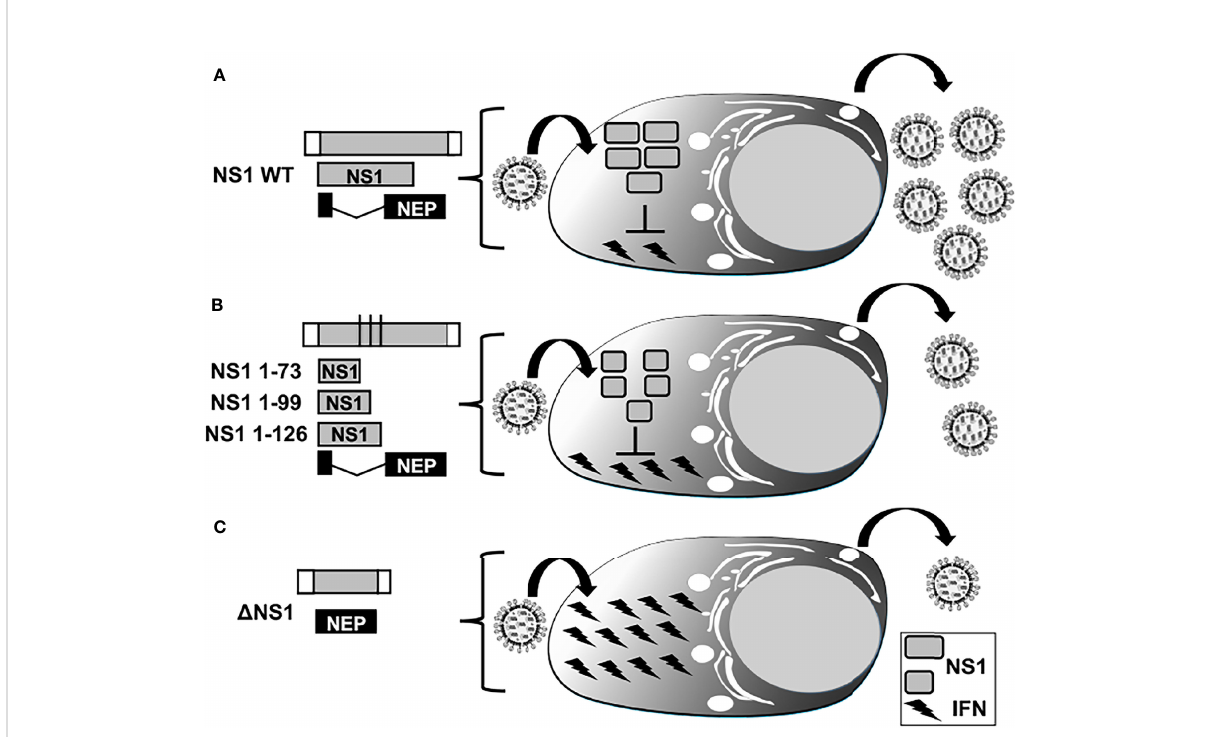
FIGURE 5 IFN responses in LAIV based on NS1 truncations or complete deletion. Representation of WT (A) , truncated (B) , or de fi cient (C) NS1 recombinant IAV. WT NS vRNA is represented in gray boxes and NCR located at the 3´and 5´ ends of the NS vRNA are indicated with white boxes. WT NS1 and NEP ORFs are represented as gray and black boxes, respectively. Black lines in panel B represent stop codons. Expression of WT NS1 protein (A) results in strong inhibition of IFN induction and, therefore, ef fi cient viral replication. NS1 1 – 73 (top), 1 – 99 (middle), or 1 – 126 (bottom) truncations in the NS1 ORF (B) or deletion of the entire NS1 ORF (C) result in less ef fi cient inhibition of IFN induction and, thus, reduced viral